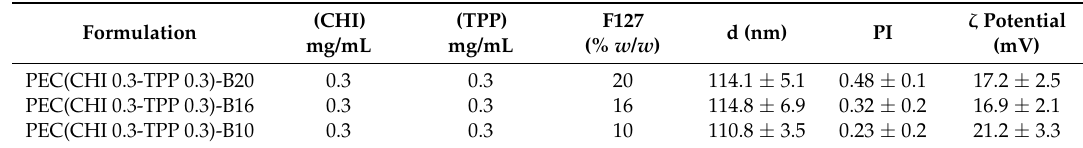
Table 3. Size, PI, and ζ potential values of different PECs. All results are expressed as mean ± SD of at least three independent experiments.